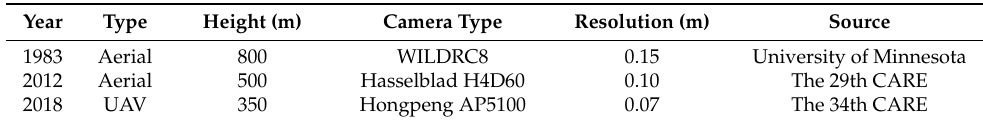
Table 1. Descriptions of the three remote sensing imagery datasets used for delineating shorelines, topography and penguin distributions on Inexpressible